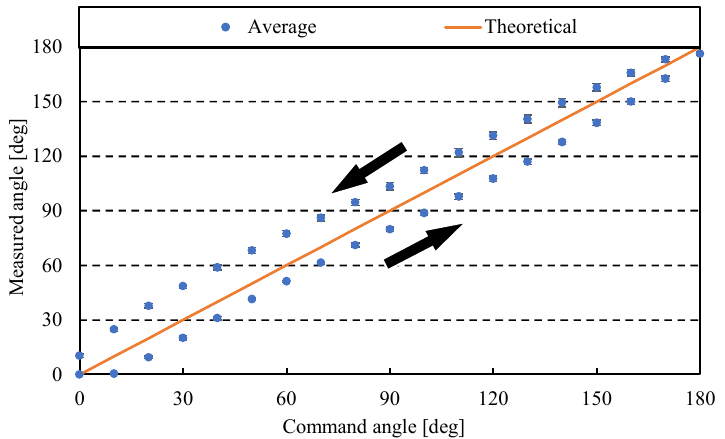
Figure 7. Measurement results of joint angles. In this graph, the vertical axis represents the measured angle, and the horizontal axis represents the target angle.